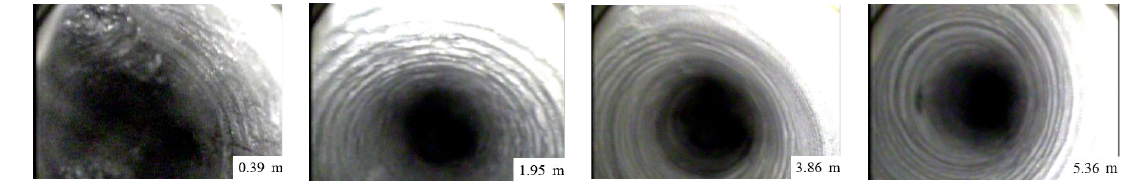
Figure 20. Borehole imaging diagram of the surrounding rock structure of the coal pillar (before the first mining).